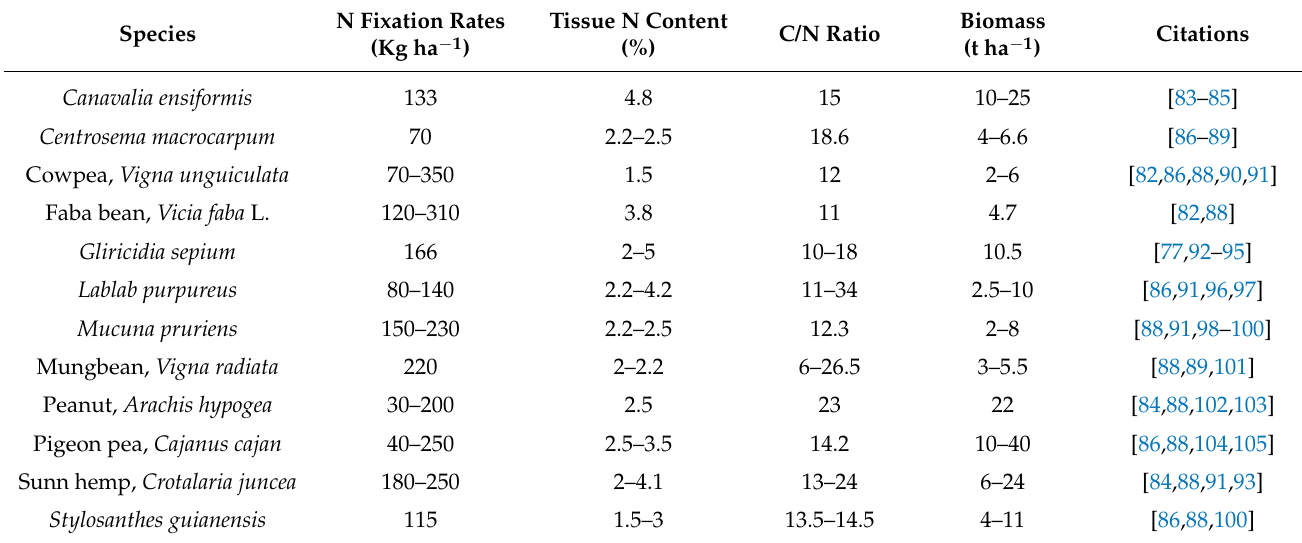
Table 2. Example of some legumes and agroforestry species used as an N source by organic and subsistence farmers 1